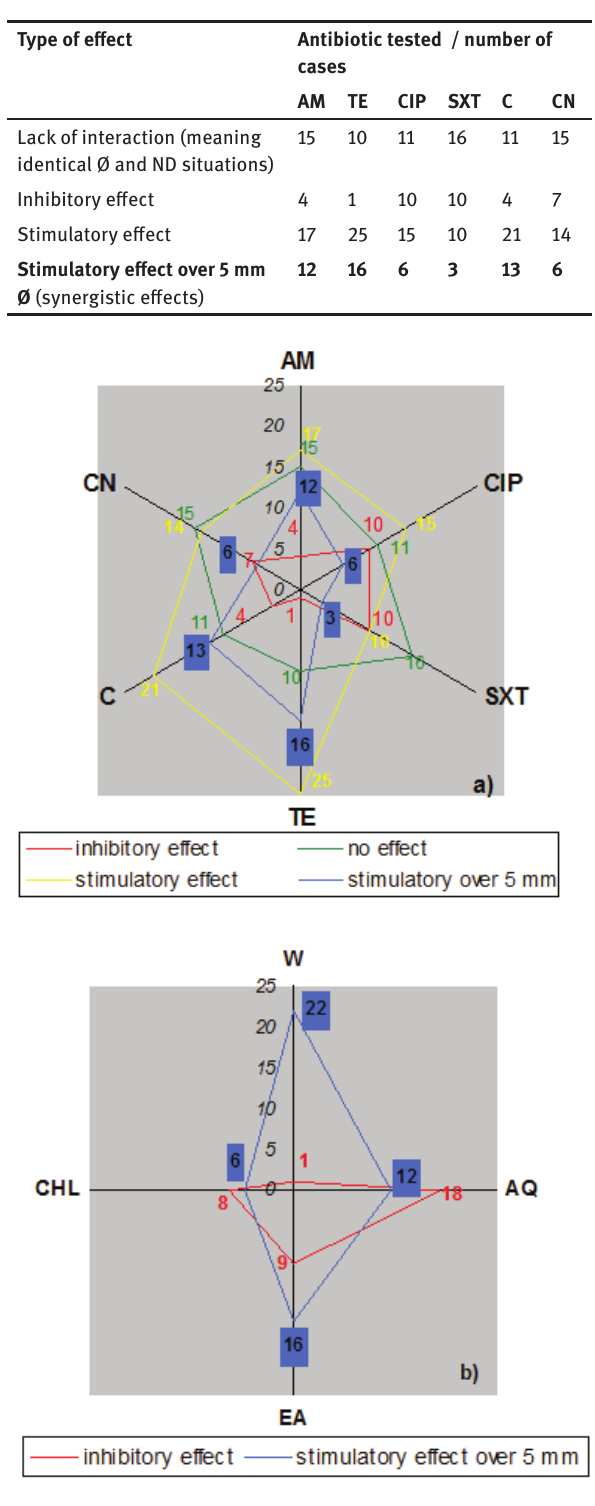
Table 3. General view of the effects of Arctii folium extracts on the six antibiotics tested.